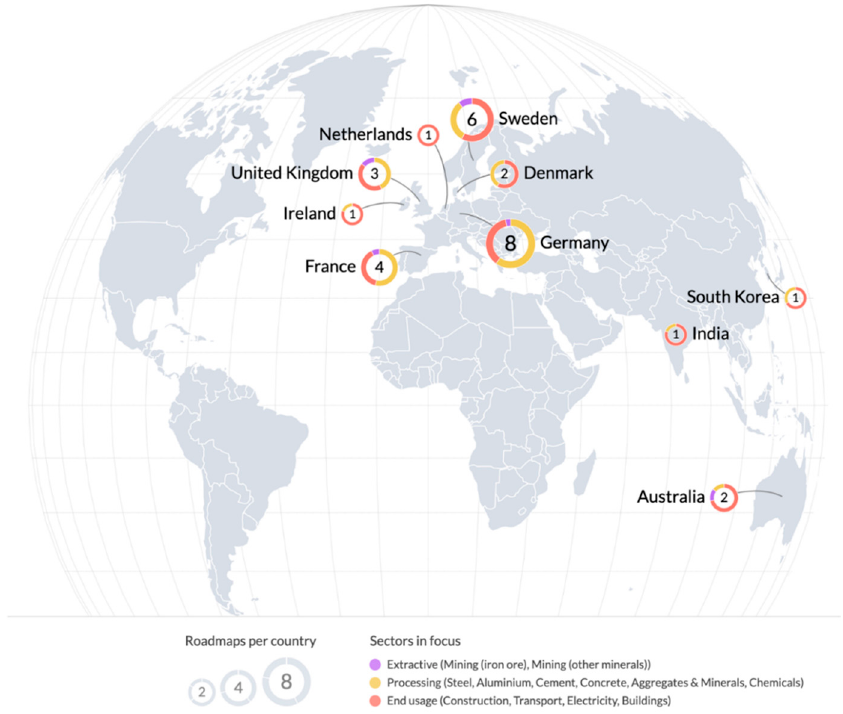
Figure 1. Overview of roadmaps and countries included in analysis (source: author’s own). Table 2. List of roadmaps included in analysis, including emission reduction targets (source: author’s own). ID # Country